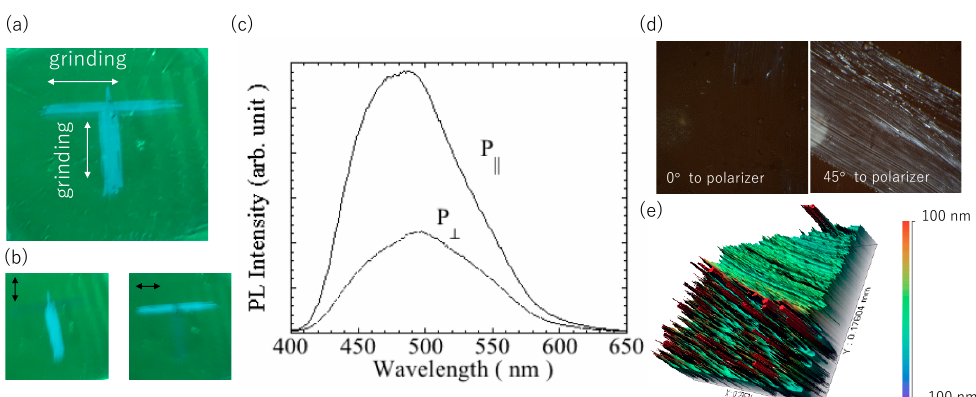
Figure 5. ( a ) Photograph of the patterned photoemission of a 2ECh film following directional grinding. ( b ) Photographs obtained using a linear polarizer, ( c ) polarized PL spectra, ( d ) polarizing optical micrograph and ( e ) surface profile of the ground thin layer. The black arrows in ( b ) indicate the polarization direction. The subscripts in ( c ) designate the directions parallel (||) and perpendicular ( ⊥ ) to the grinding direction.